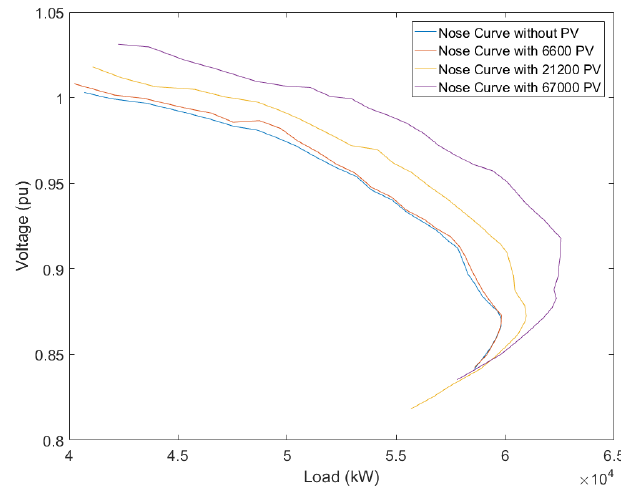
Figure 3. Nose curve with and without PV for selected bus associated with transmission line with the least stability margin.